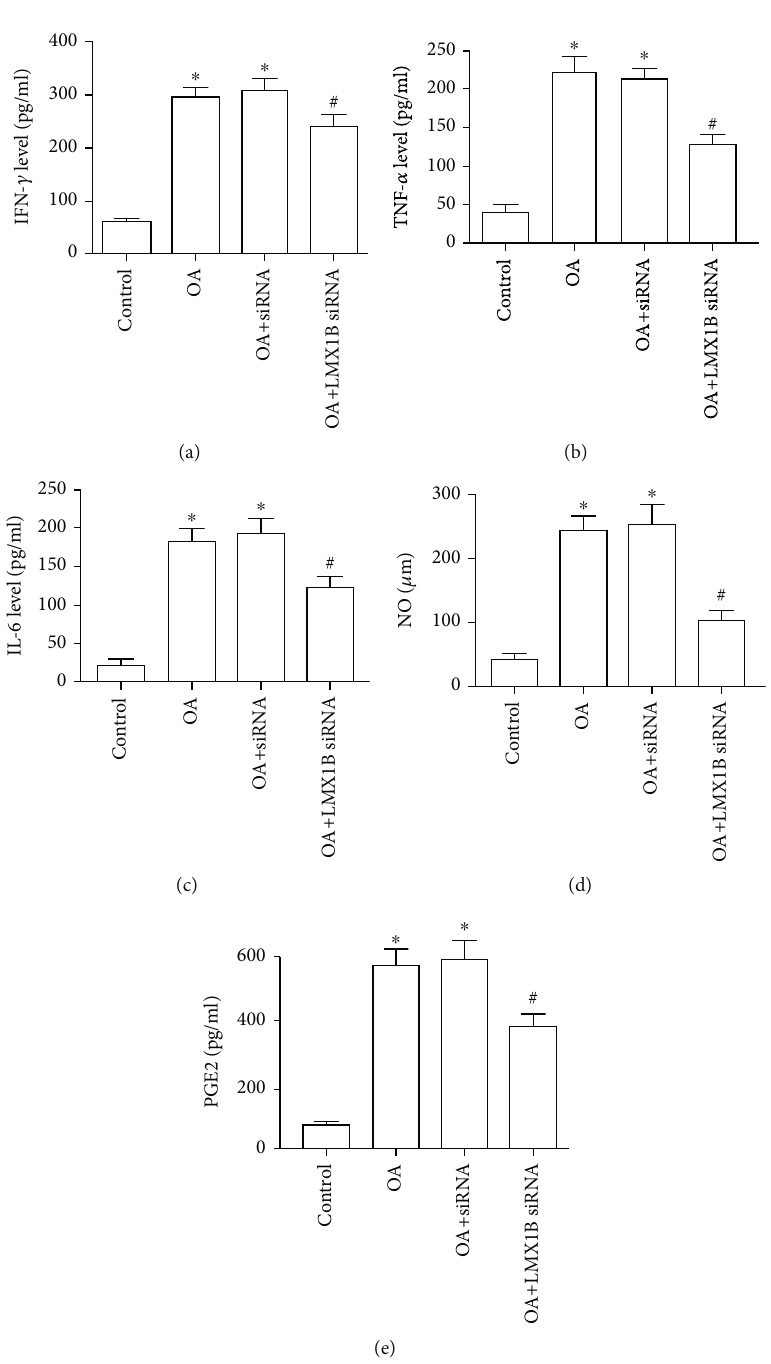
Figure 10: LMX1B depletion suppressed in fl ammatory cytokines secretion in OA rats. ELISA kits were used to determine the expression of IFN- γ (a), TNF- α (b), IL-6 (c), and PGE2 (e); (d) NO concentration was determined by the Griess reaction. ∗ P < 0 : 05 , compared with the control group; # P < 0 : 05 , compared with the OA group. In the study, 7 rats were used in each 1 β -induced SW1353 cells. Cell apoptosis, IFN- γ , TNF- α , IL- 6, PGE2, NO, MMP3, and MMP13 expressions were aug-